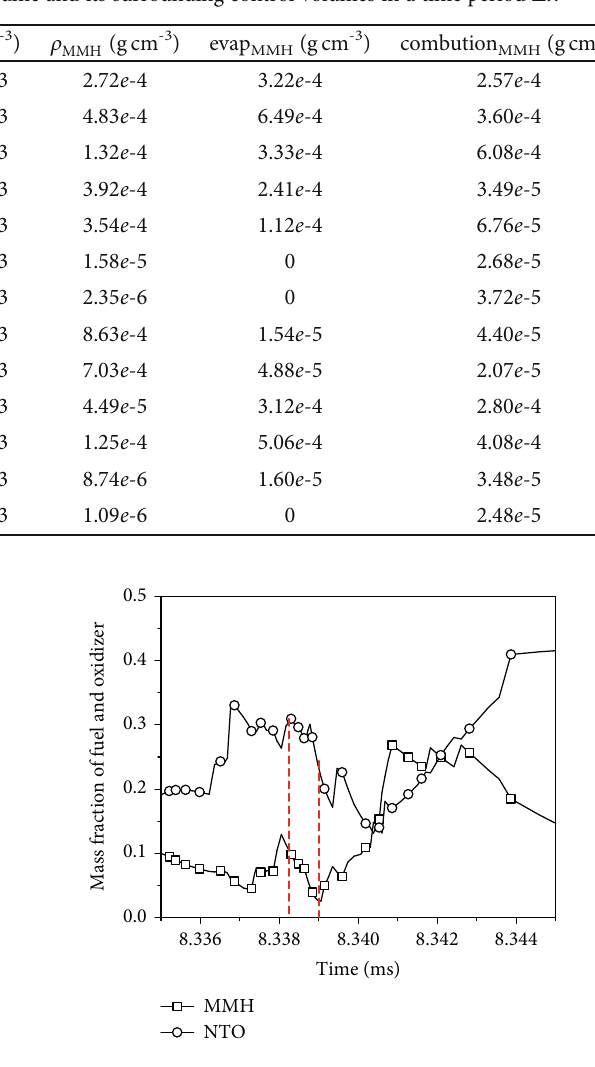
Figure 11: The mass density of MMH and